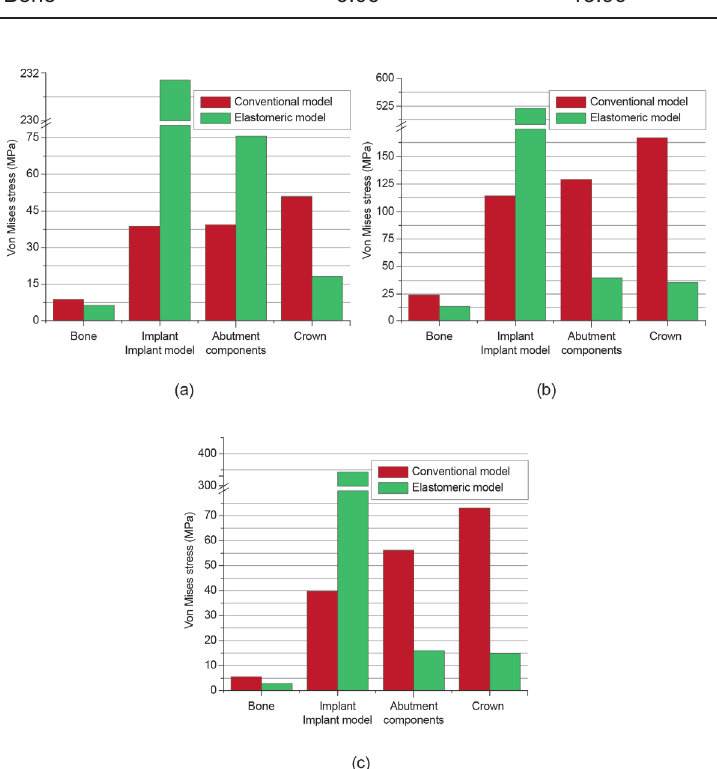
Figure 7- Von Mises stress levels for each component in the two models under different load cases. (a) Corono-apical load, (b) Linguo-buccal load, (c) Disto-mesial